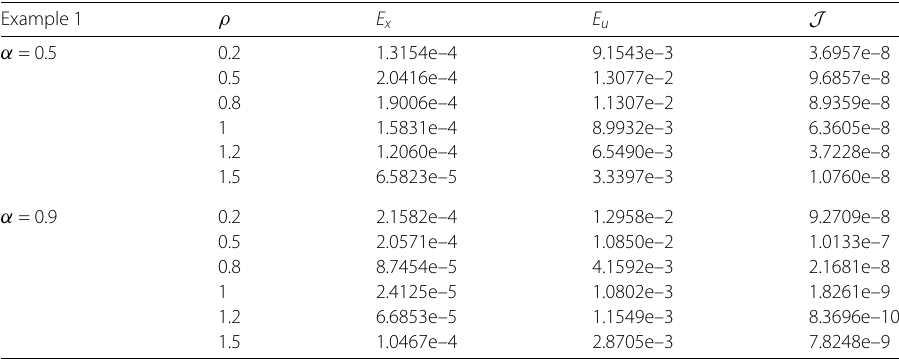
Table 4 The maximum absolute errors E x and E u at N = 7 and various values of α , ρ for x ( t ) and u ( t ), respectively Example 1 ρ E x E u J α = 0.5 0.2